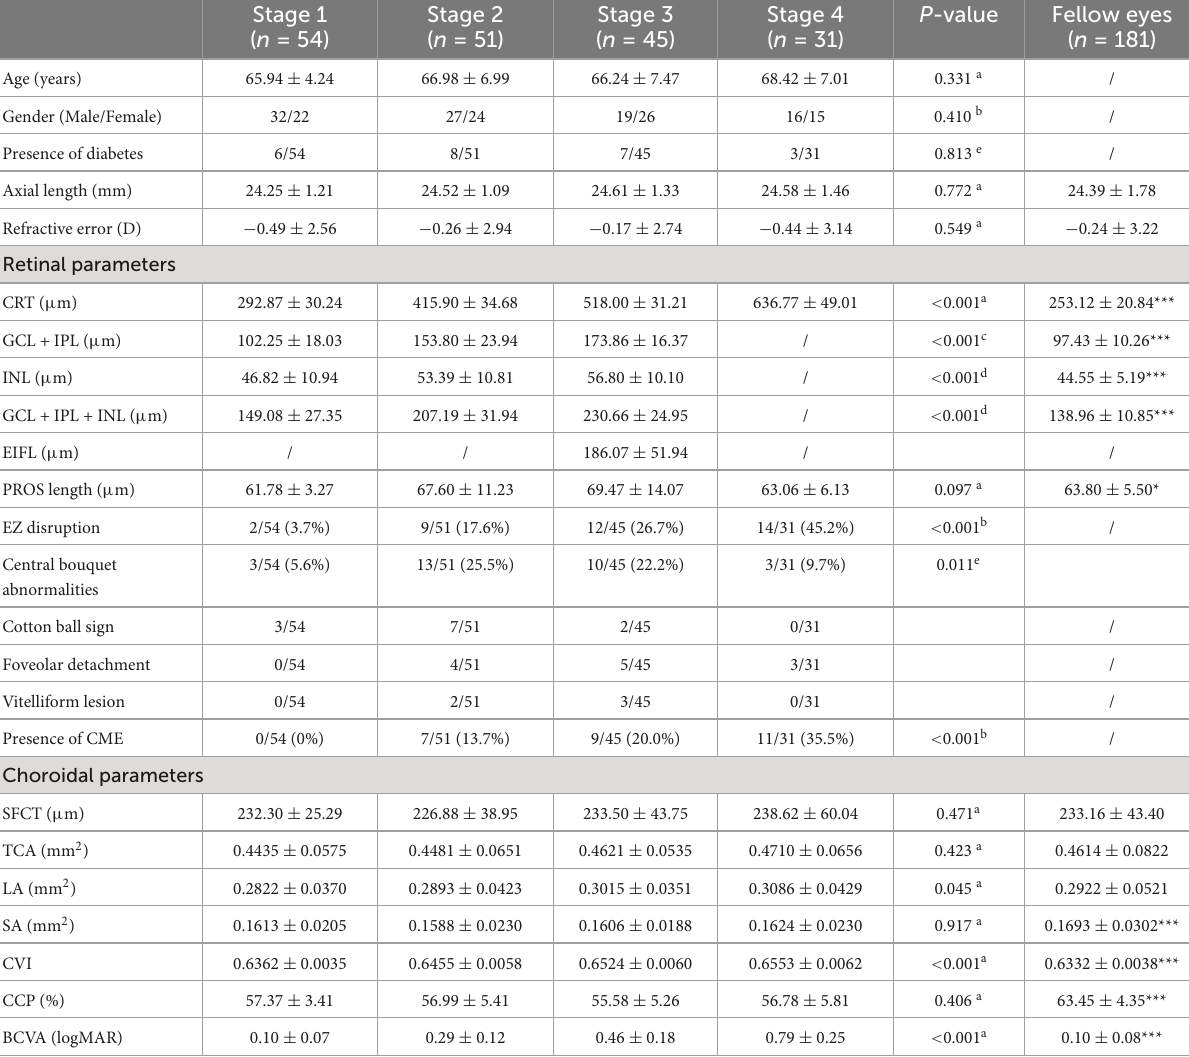
TABLE 1 Demographics and ocular characteristics in different stages of idiopathic epiretinal membrane and fellow